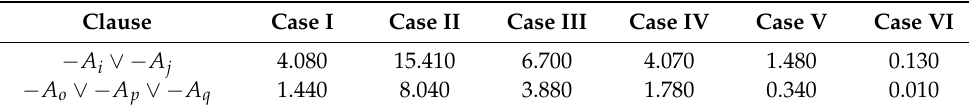
( e ) MAE , ( b ) RMSE , ( c ) MAE , ( d ) RMSE , and ( e ) energy energy test test = NN 100 .